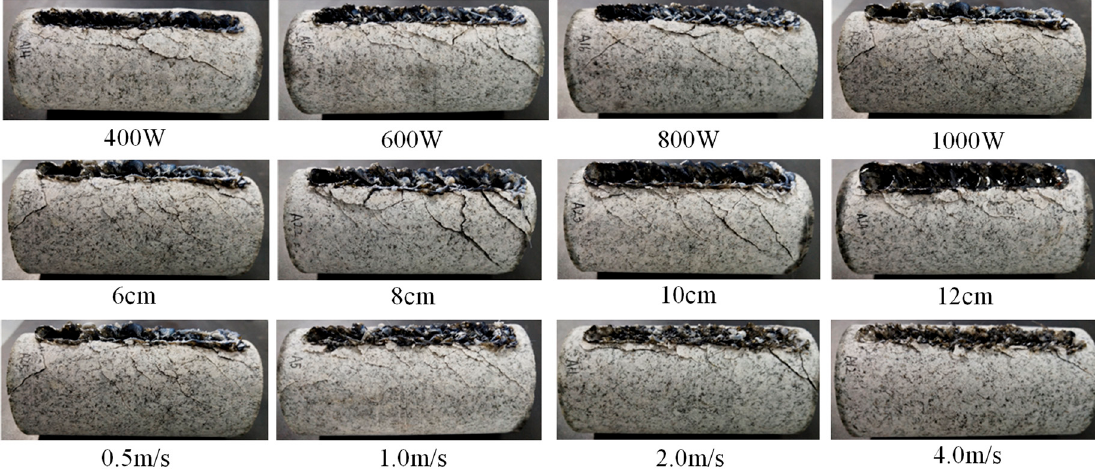
Figure 8. Cracks of irradiated granite on the lateral surface.